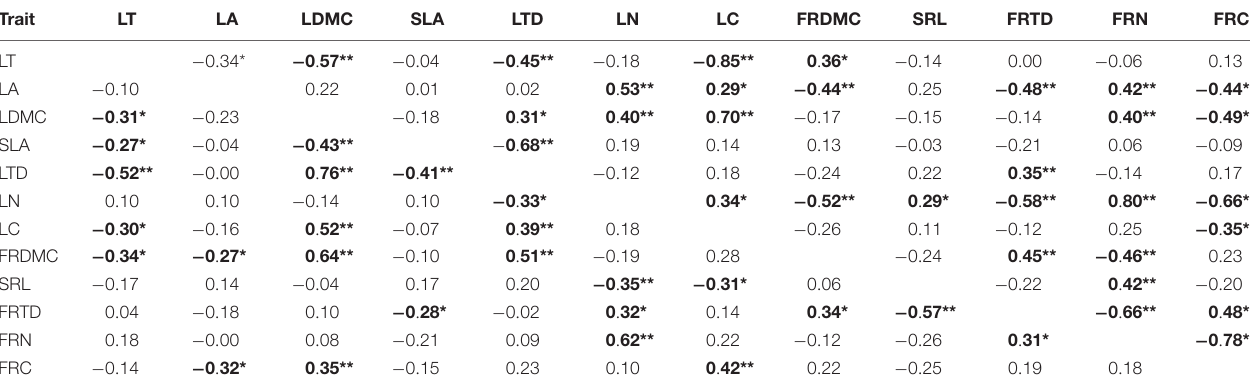
TABLE 2 | Matrix of Pearson’s correlation coefficients for the relationships between leaf and fine root traits of 54 dominant species ( n = 54). Trait LT